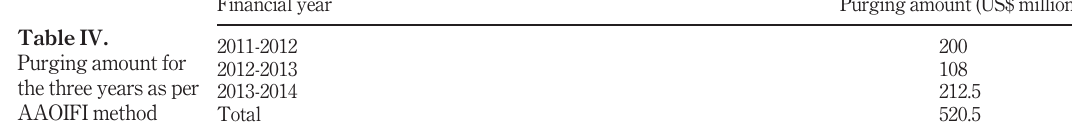
Table III. Purging amount for the three years as per dividend method